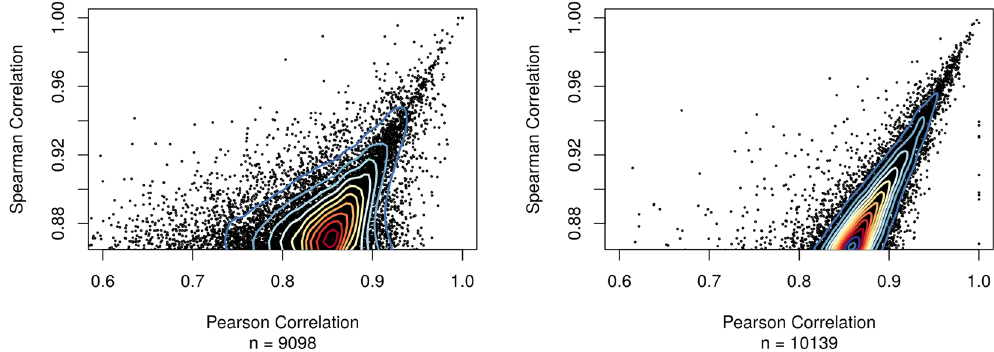
Figure 5. Non-GMM vs GMM PCC and SCC values. ( A ) The scatterplot of Pearson vs Spearman correlation from the edges of a cancer network constructed using the same input dataset, but created without usage of GMMs. ( B ) A similar plot but from the GMM network. The number of points in both panels (corresponding to edges in the network) is indicated by the variable n . Contour lines have been added to indicate point